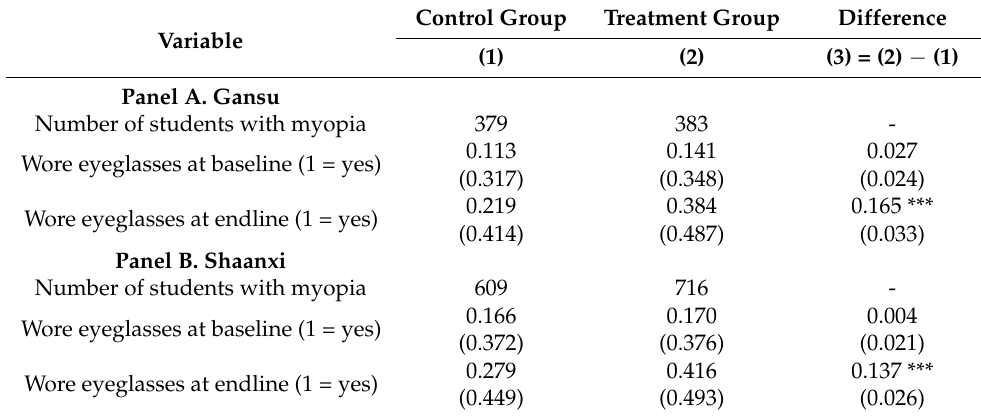
Table 3. Compliance rate at baseline and endline.